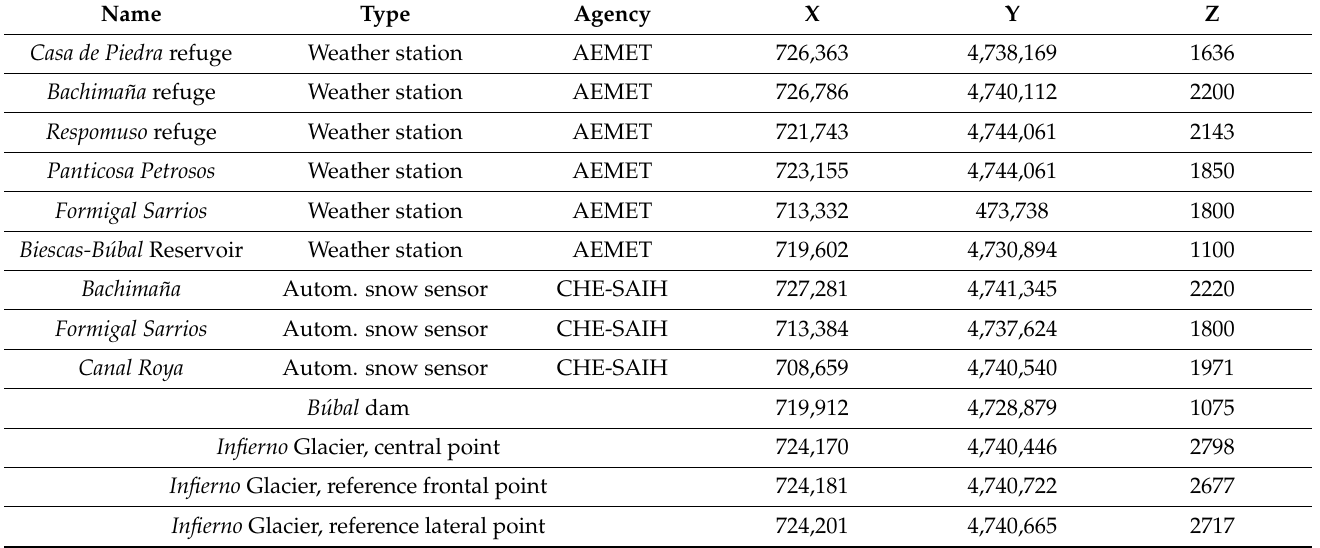
Table 1. Location of weather stations and snow sensors in the upper G á llego River basin up to the B ú bal Reservoir, and Infierno Glacier monitoring stations. All UTM coordinates, ETRS89. Topographic zone: